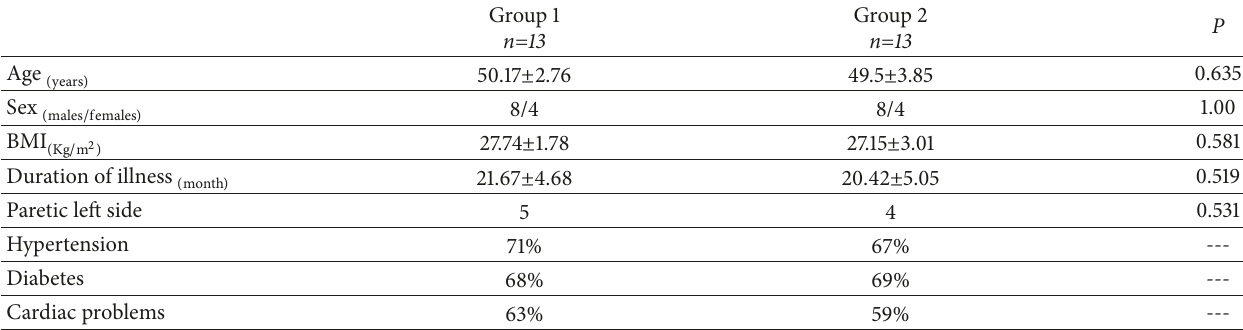
Table 1: Subject characteristics, values presented as (mean ± SD), and